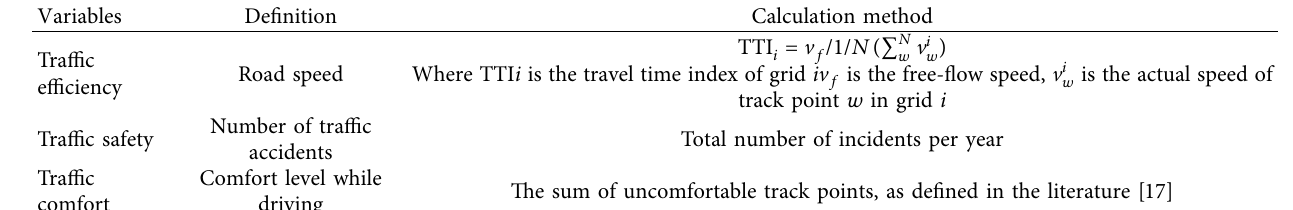
Table 2: Definition and calculation method of TSS indicators.